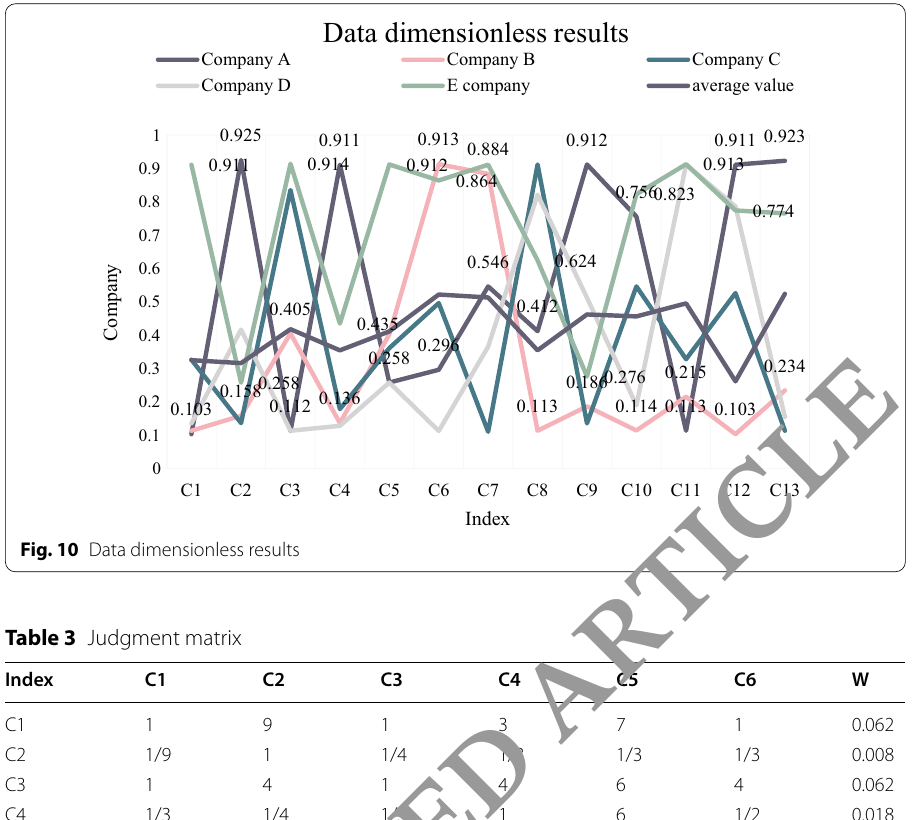
Fig. 10 Data dimensionless results